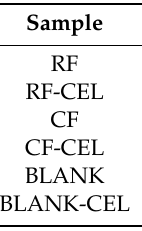
Table 7. Hydrolysis rate constant values estimated using Equation